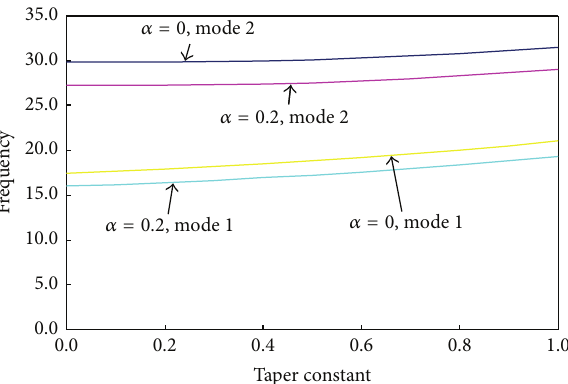
Figure 2: Value of frequency parameter for orthotropic trapezoidal plates for different values of taper constant and fixed values for 𝑎/𝑏 = 1.0 , 𝑐/𝑏 = 0.75 .